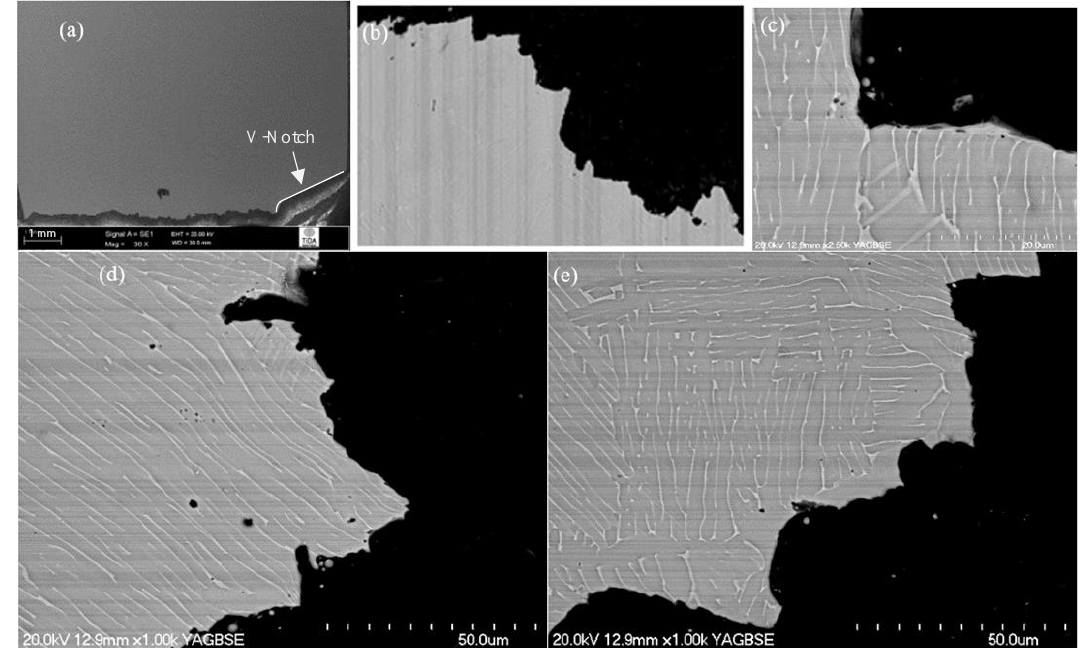
Figure 7. Crack propagation behaviour of 925 °C/4 h, CFC@50 °C/h to 760 °C, FC treated material: ( a,b ) overall crack path; ( c ) interaction with β phase; ( d,e ) different forms of α phase providing sufficient resistance to crack growth.